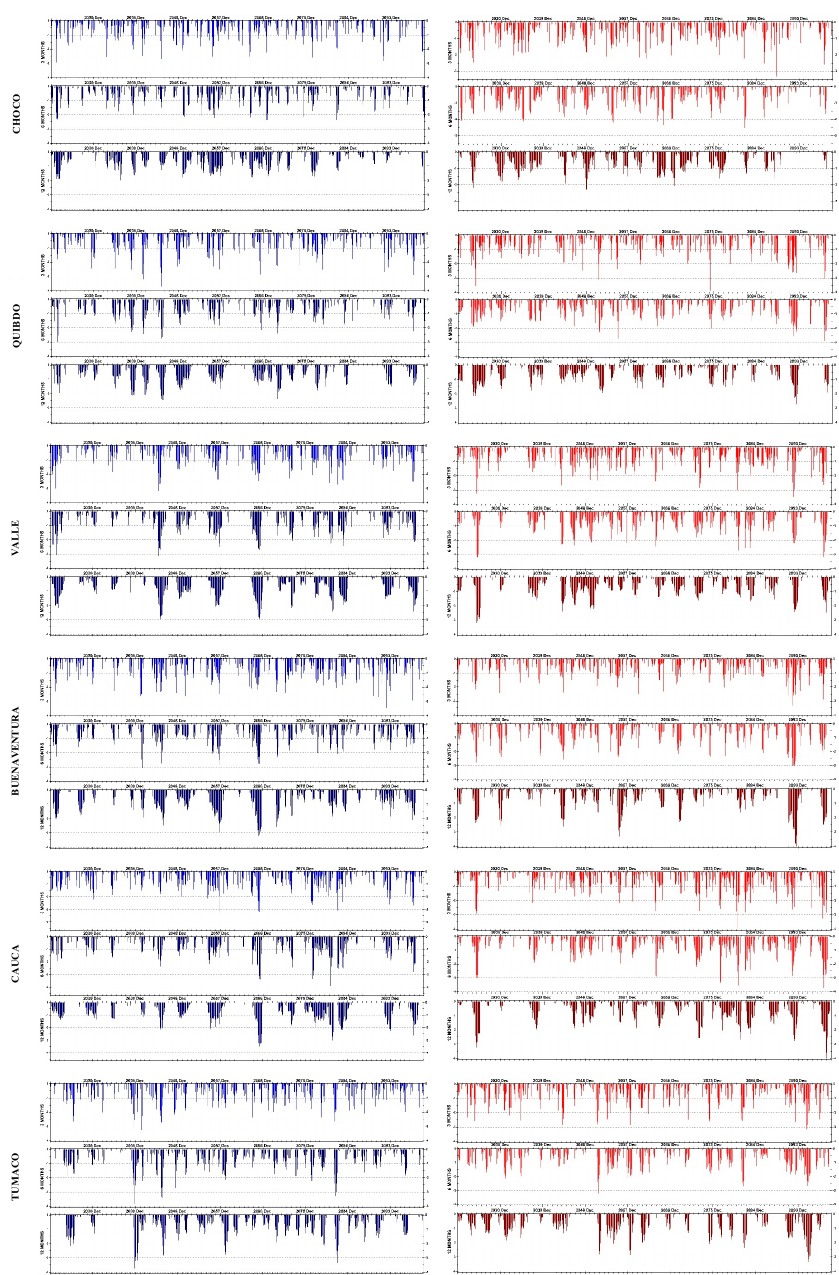
Figure 5. Projected dryness in Colombia’s Pacific region (six locations), 2022–2100. SPIs at different timescales.